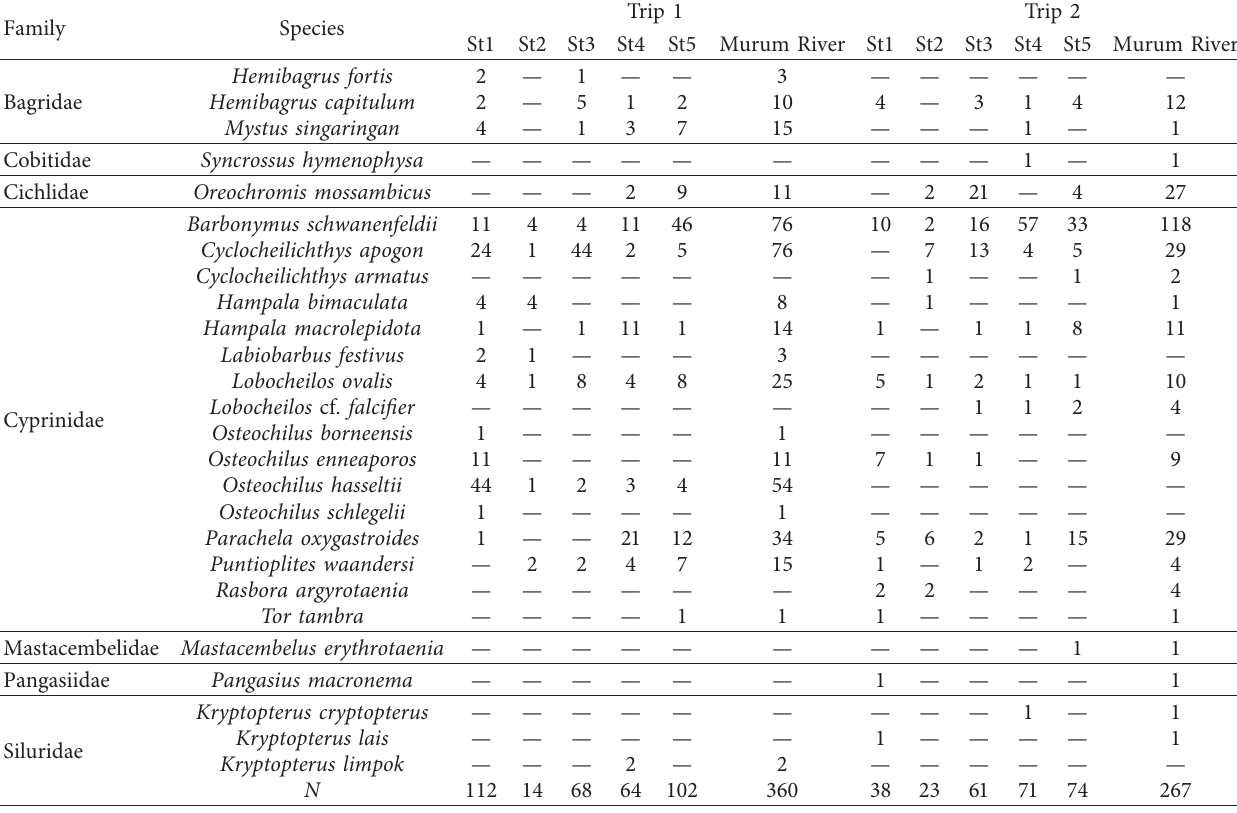
Table 1: The list of fish composition in the Murum River during the dry (trip 1) and wet (trip 2) seasons. Family